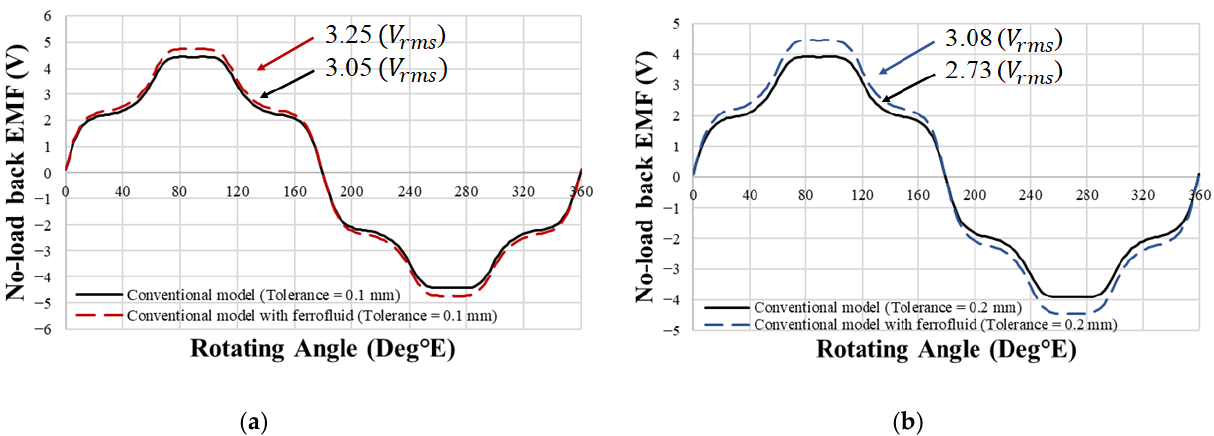
Figure 7. No-load back electromotive force (EMF) analysis (4000 rpm): ( a ) magnet tolerance = 0.1 mm; ( b ) magnet tolerance = 0.2 mm.